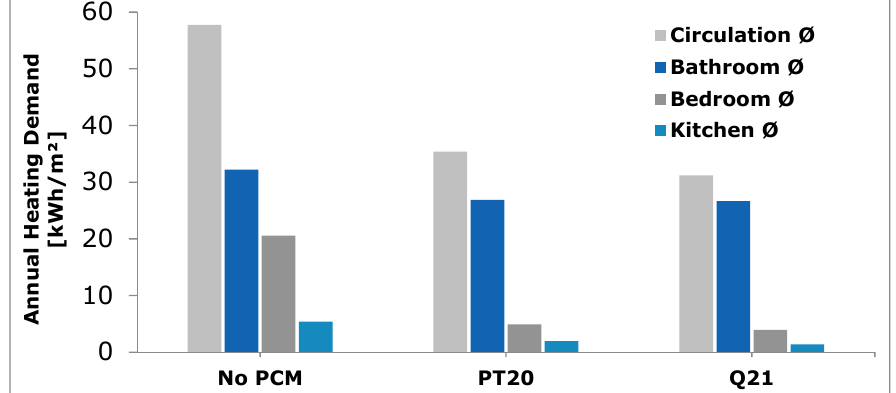
Figure 7. Zonal annual heating demand for NV building B (without PCM and with PCMs of 3 mm thickness).